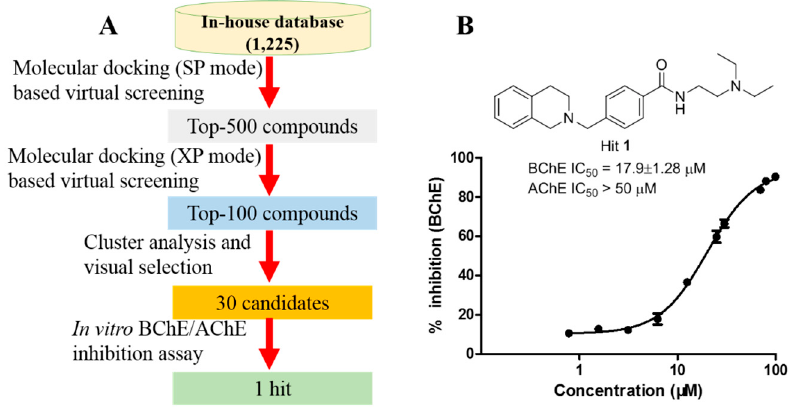
Figure 1. In silico screening procedure and ChE assay results of hit 1 . ( A ) The discovery workflow of the hit compound. ( B ) Chemical structure of hit 1 and its ChE inhibitory activity.